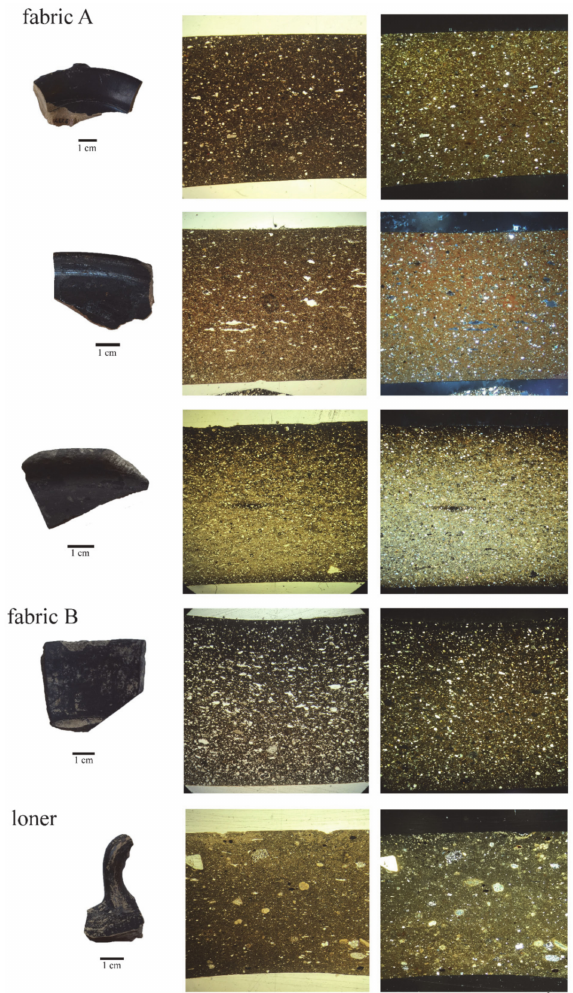
Figure 2. Microscopic images of representative samples for each fabric, from top to bottom: sample 4026-102 (fabric A-fine, Black-Gloss Ware), sample 4032-104 (fabric A-fine, Black-Gloss Ware), sample 4020-107 (fabric A-fine, Bucchero), sample 4026-110 (fabric B-coarse, Bucchero), sample 4032-103 (loner, Black-Gloss Ware). Table 3. Mineralogical composition of bucchero and black-gloss ware (BGW) samples.